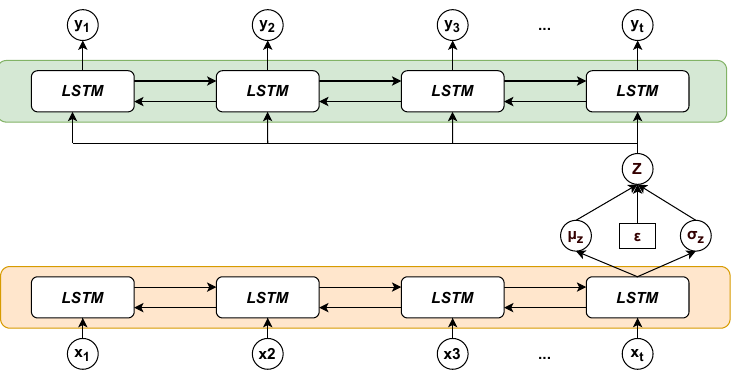
Figure 5. Architecture of the used VAE. The encoder is represented in orange and the decoder in green, with bi-directional layers of Long Short-Term Memory cells in each direction and the latent space Z modeled according to an isotropic normal distribution (with parameters µ z and σ z